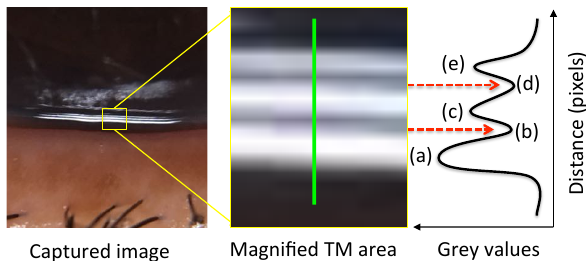
Figure 5. The relationship between the three lines on the TM and the peak position in the graph.